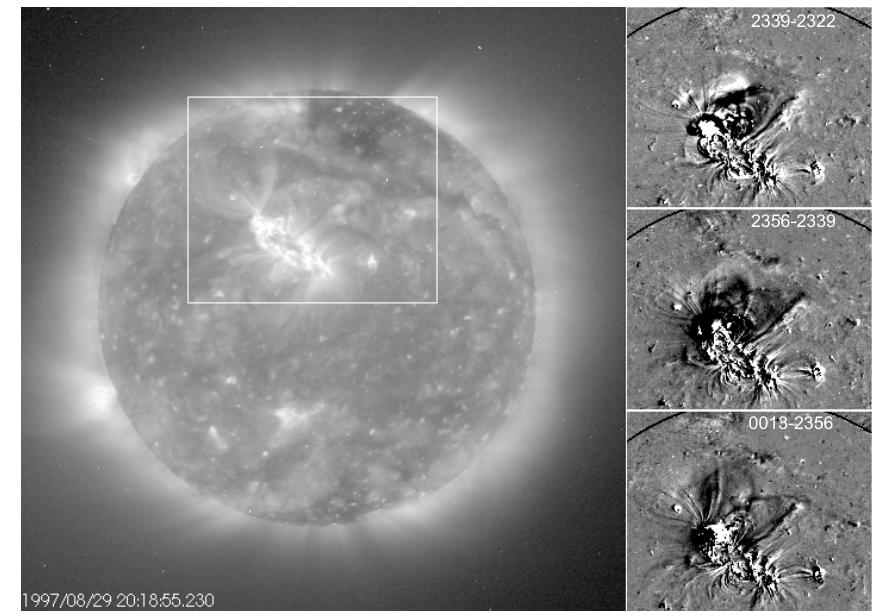
sun disk enclosed by the white box appears on the right. On the right, from top to bottom, panels order image differences chronologically, illustrating the advance on the low corona of the EIT-wave (changing location white and dark